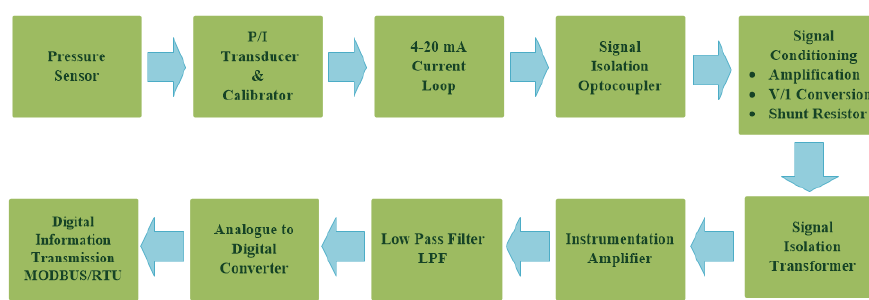
Figure 3. 4–20 mA analogue pressure transmitter as a part of automation system.